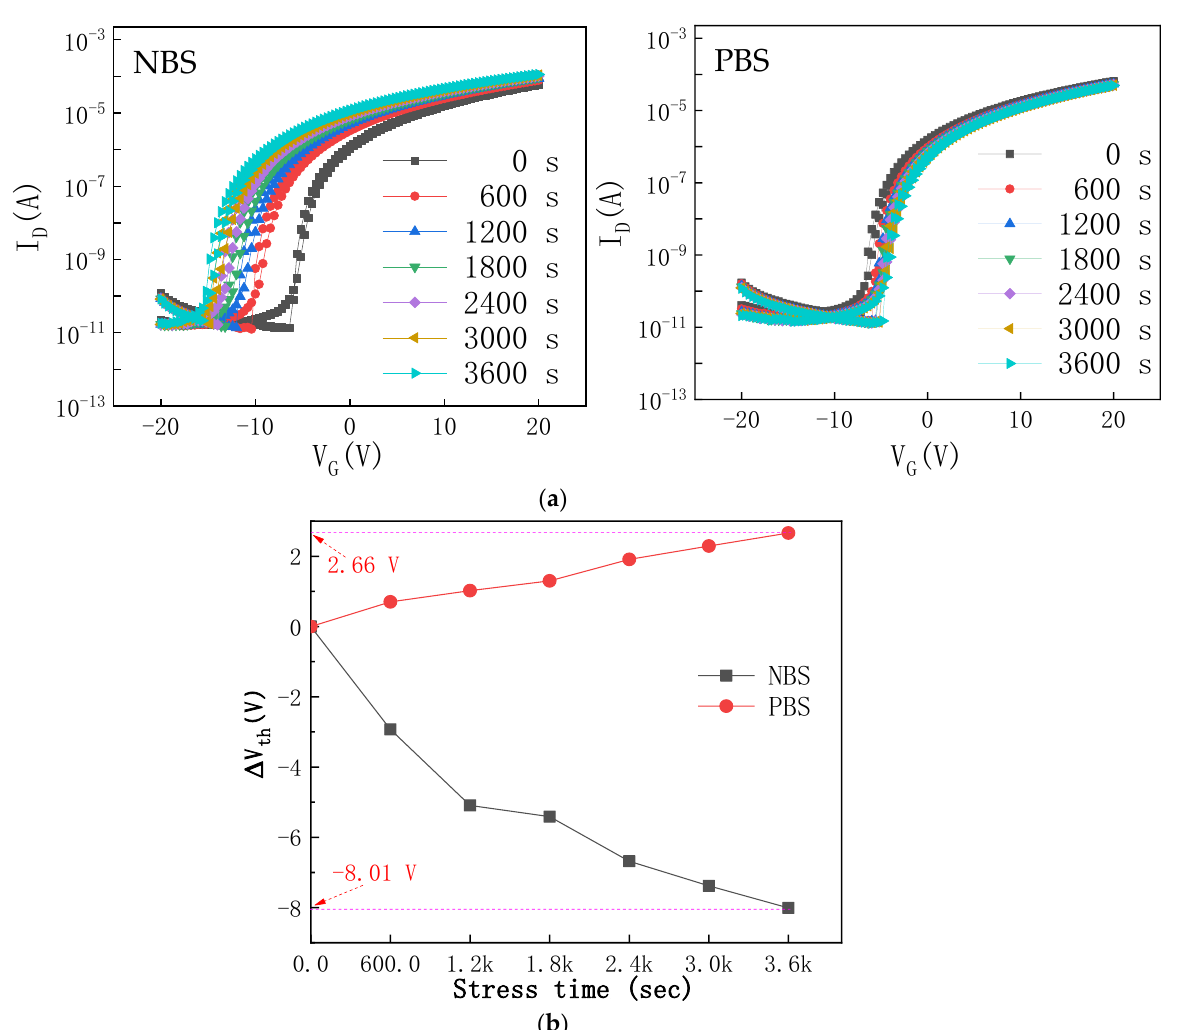
Figure 10. ( a ) Transfer curves of ZATO TFT annealed at 623 K under NBS (V G = −20 V) and PBS (V G = 20 V), and ( b ) the shifts of V th ( △ V th ) under NBS/PBS.